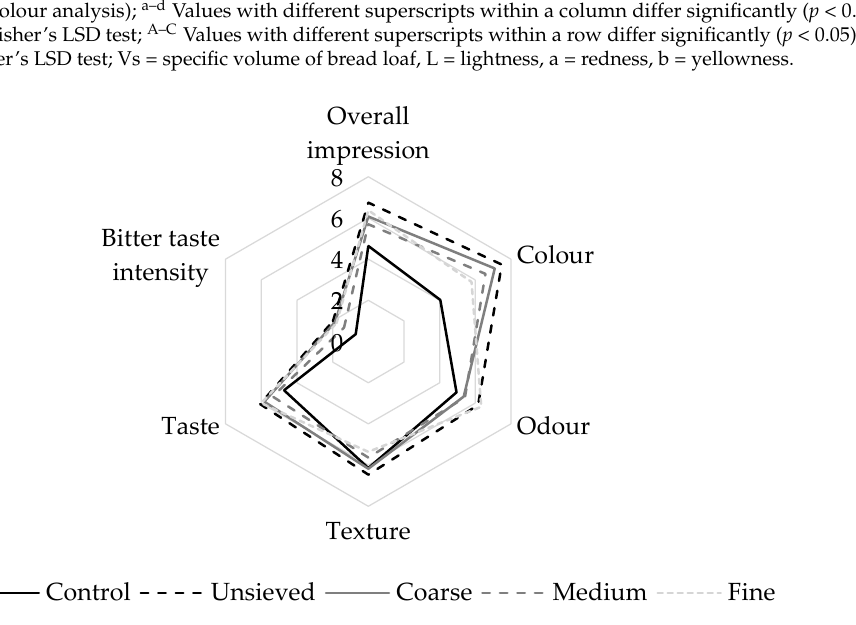
Figure 1. Sensory analysis of the control bread and breads fortified with different fractions of milk thistle oilseed cake.